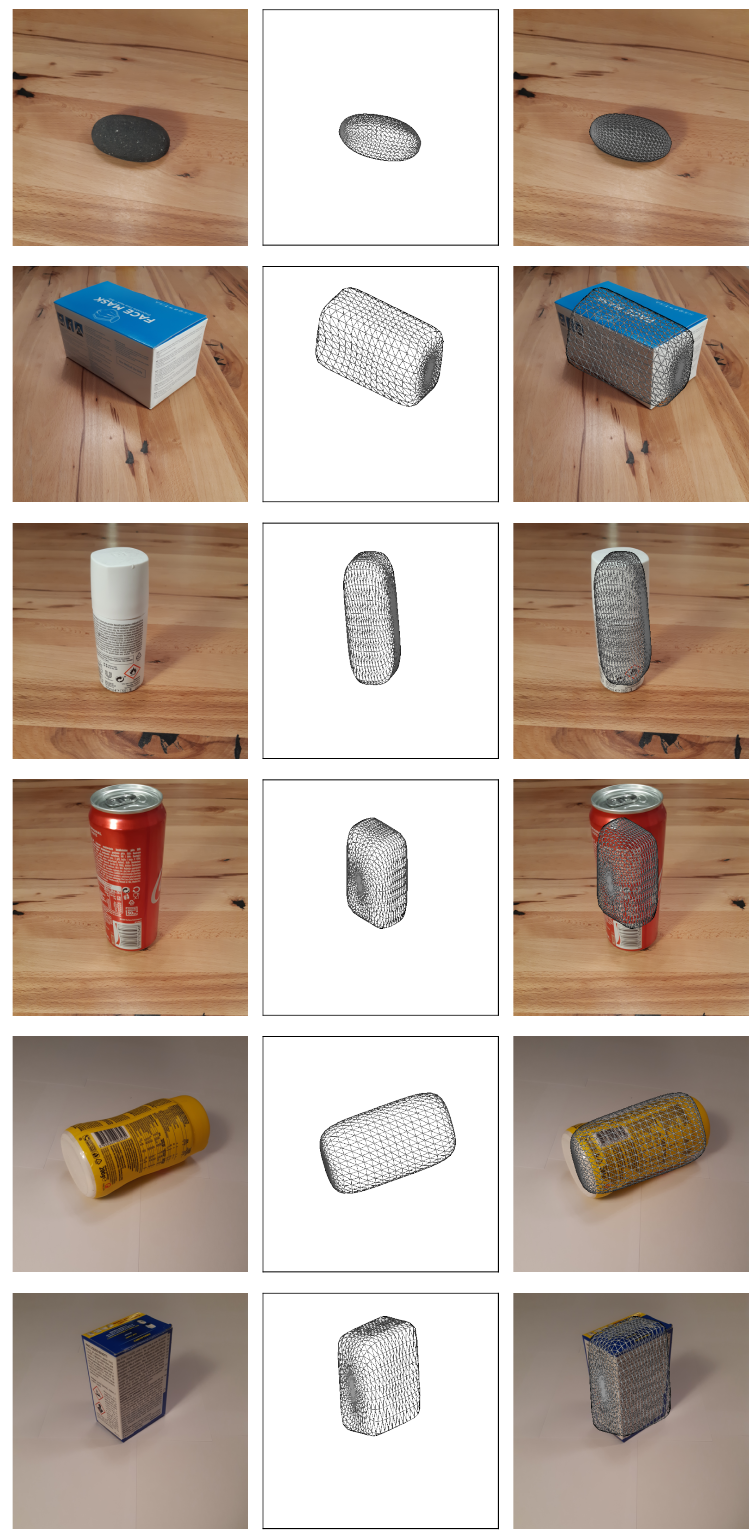
Figure 13. Qualitative results on real images obtained with our final CNN predictor trained on artificial data ( Textured on Wood (Fixed z) with Sh. & S.L. ). The first column depicts the input images, while the second column shows the predicted superquadric in a wireframe form. The last column combines the two images for easier